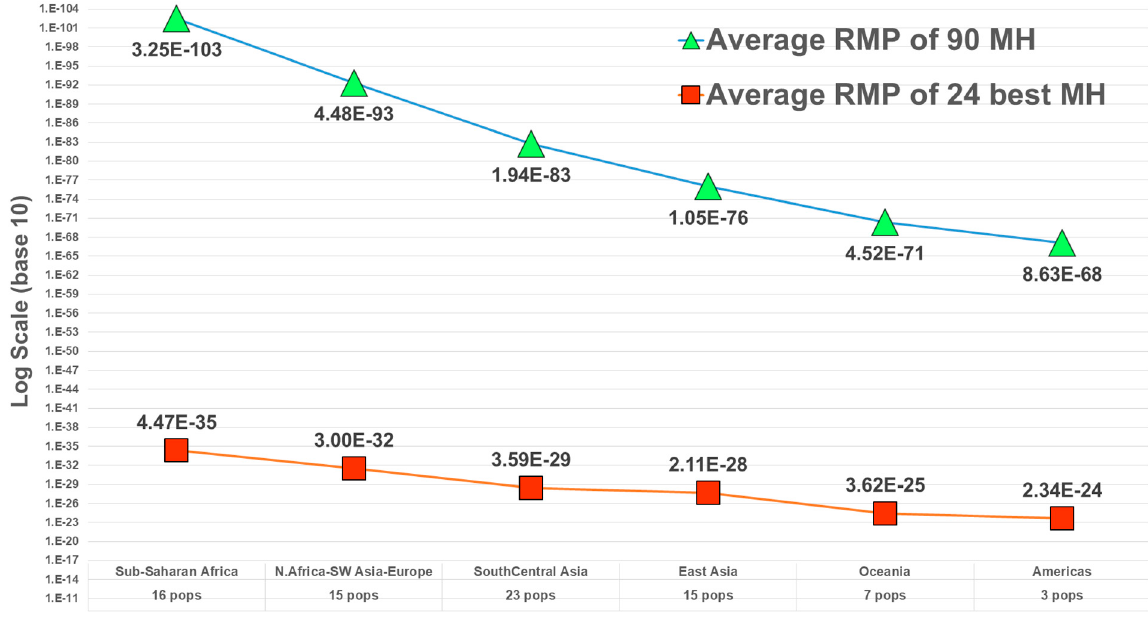
Figure 3. Average RMP in major world regions for a dataset of 90 MHs and 79 populations (from [14]) and for the best subset of 24 MHs [13].